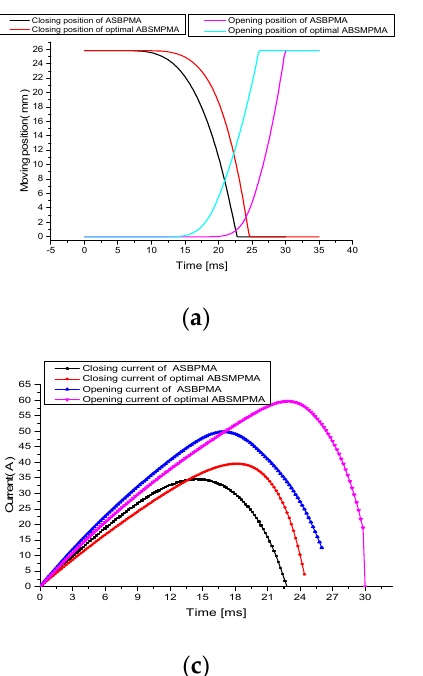
Figure 11. The closing and opening characteristics of the ASBPMA and optimal ABSMPMA are shown. ( a ) The closing and opening moving position characteristics. ( b ) The closing and opening speed characteristics. ( c ) The closing and opening armature current characteristics.